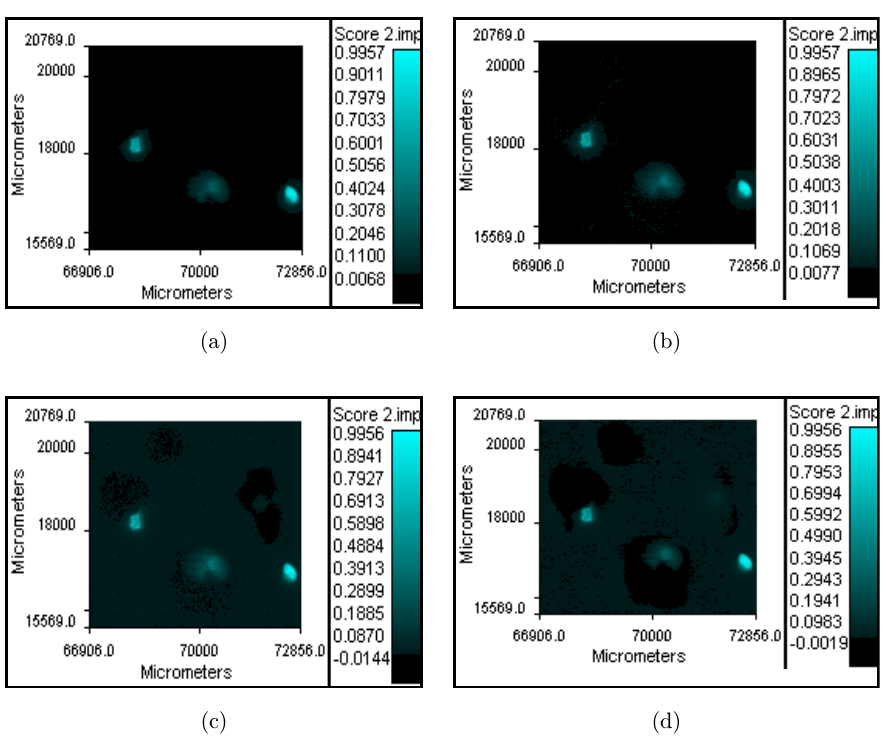
Fig. 6. Second score images of PCA analysis with di®erent preprocessing. (a) Baseline o®set correction. (b) First derivative. (c) Second derivative. (d) Noise